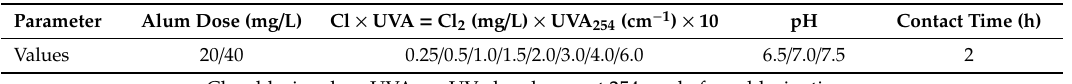
Table 1. Experimental parameters for raw water (RW) clarification and chlorination.